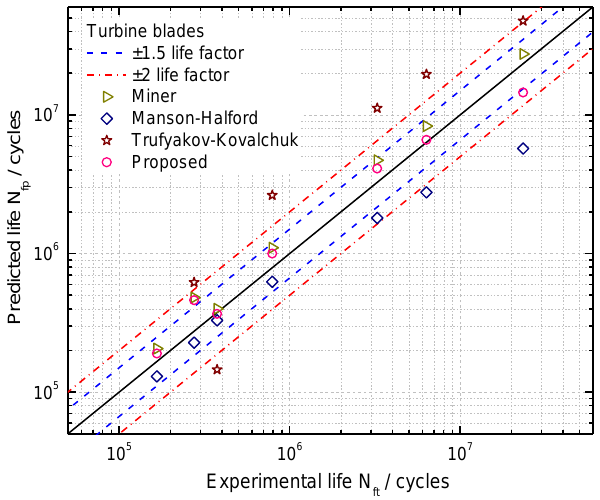
Figure 8. CCF life prediction results of turbine blades.